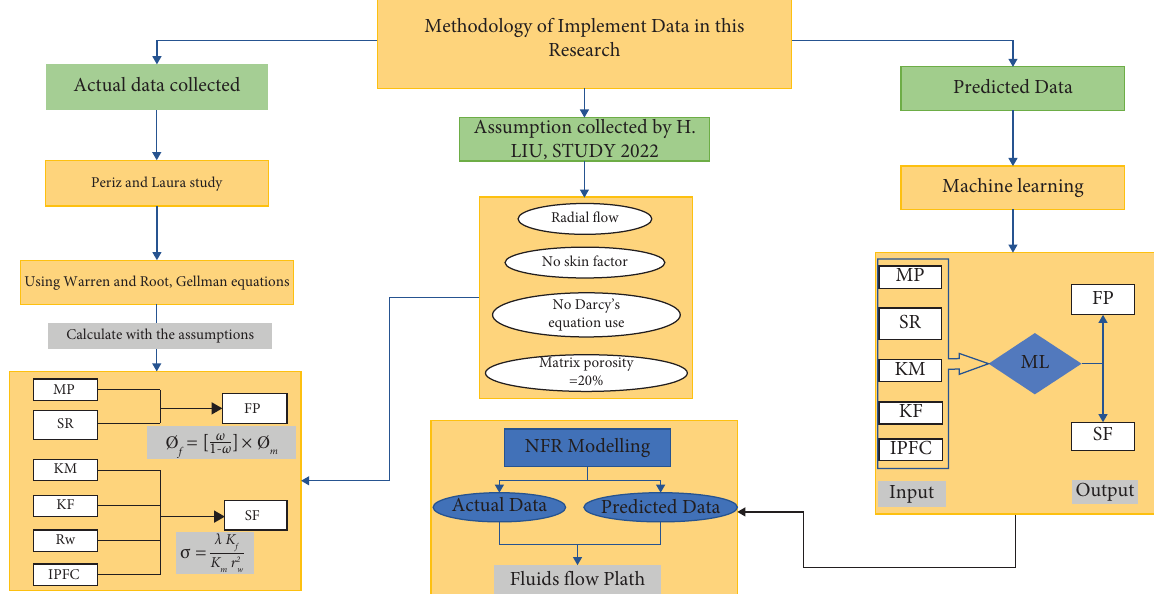
Figure 2: Methodology of databases modeling